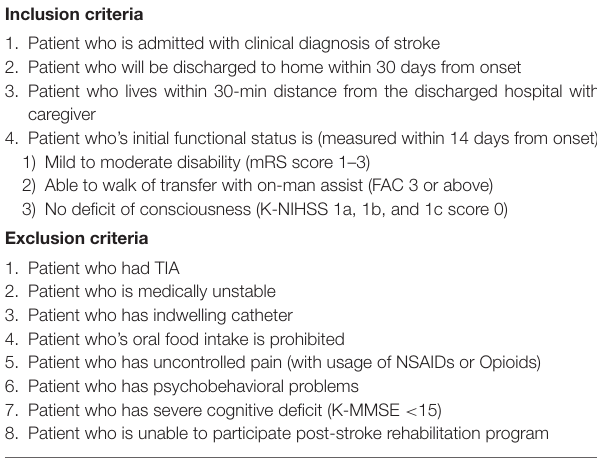
TABLE 1 | Inclusion and exclusion